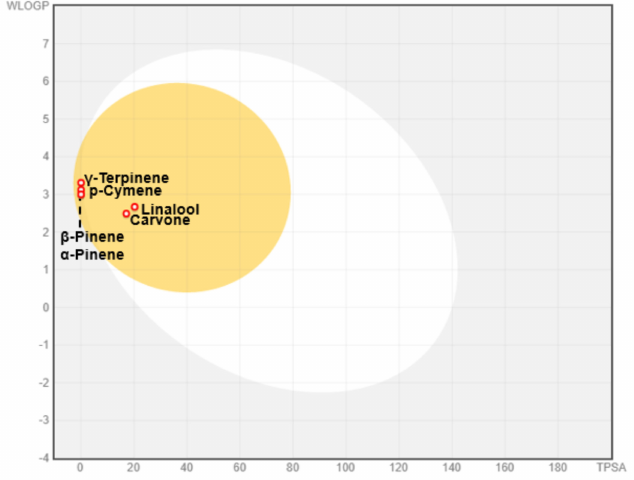
Figure 2. Boiled egg plot of WLogP vs. TPSA. Yellow indicates BBB-permeant, white indicates gastrointestinal permeant, blue indicates P-glycoprotein, and red indicates